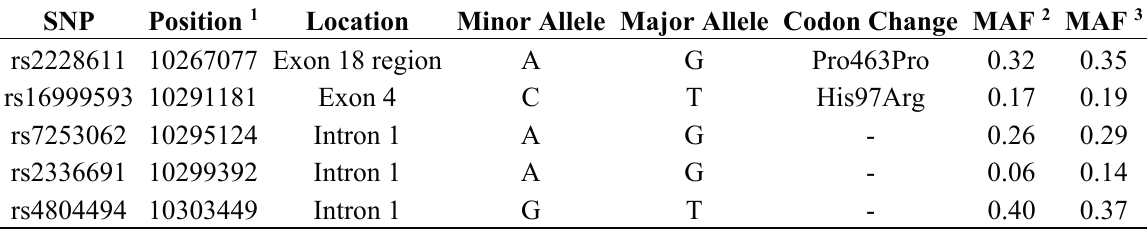
Table 2. Characteristics of SNPs in DNMT1